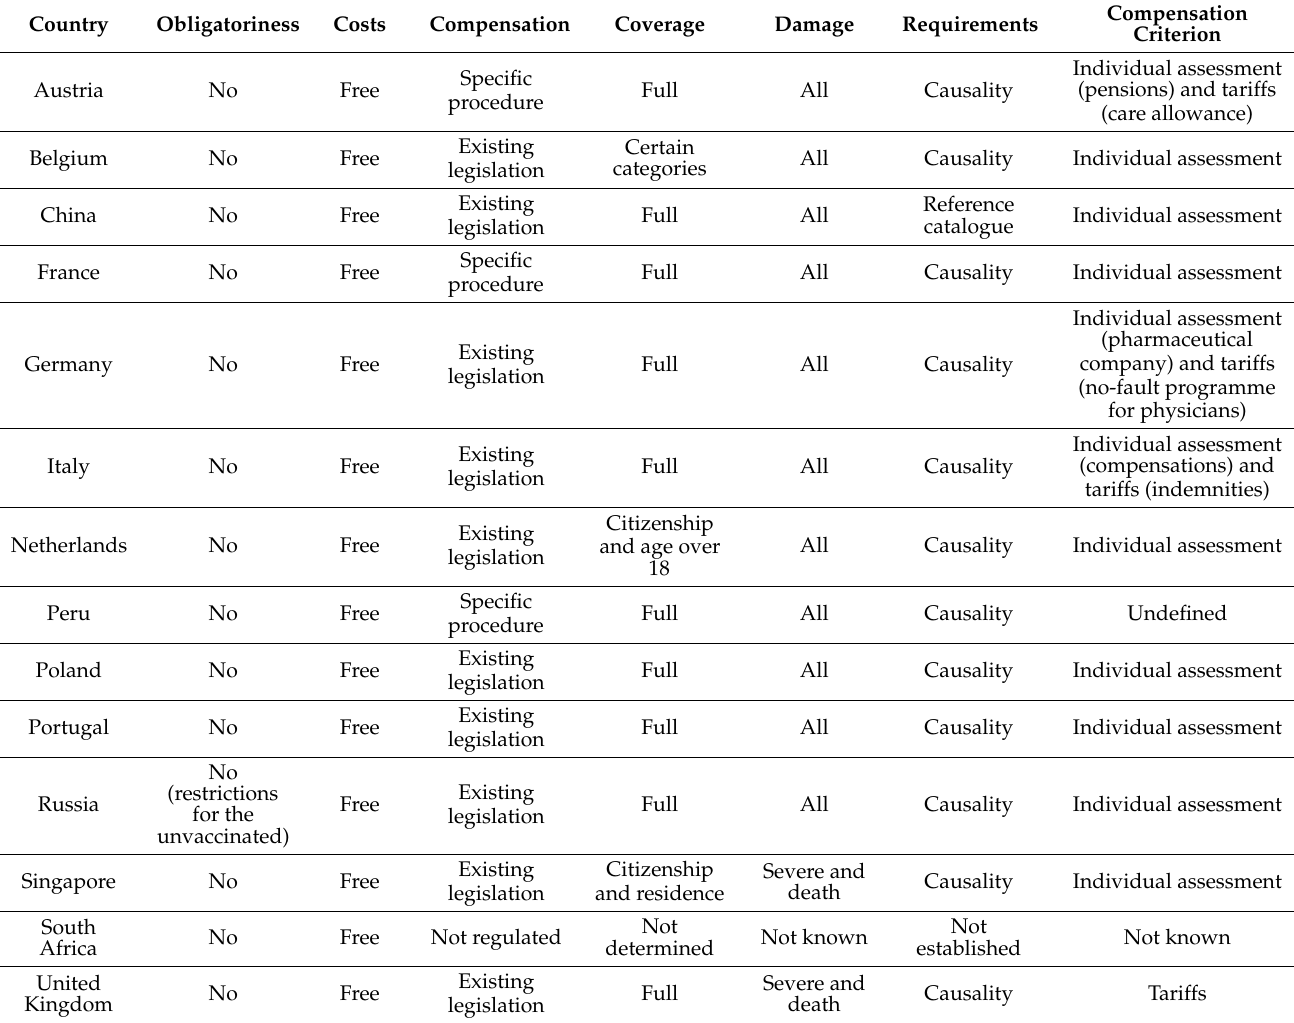
Table 1. COVID-19 vaccine compensation regimes in different